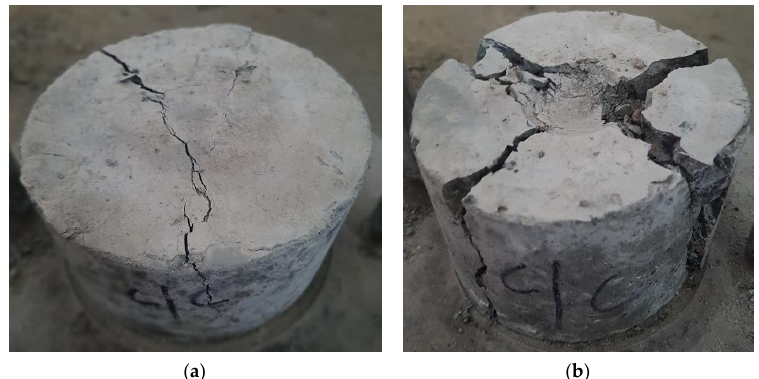
Figure 15. Impact energy for the mixture incorporating various rubber sizes and dosages.